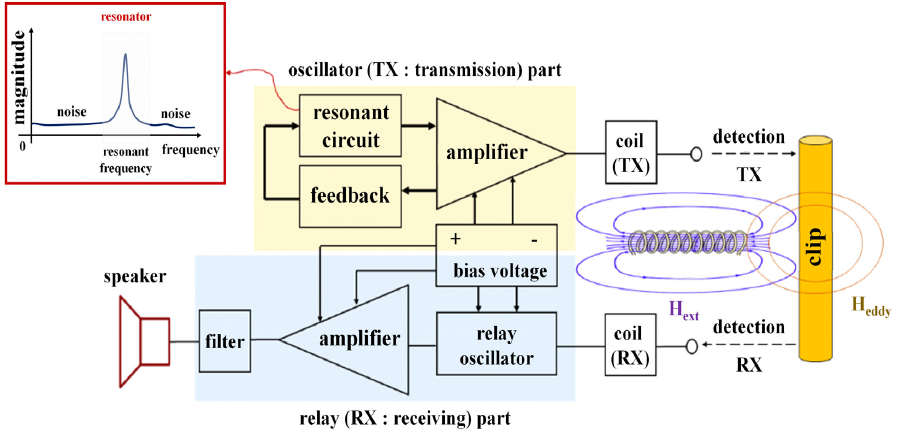
Figure 6. Block diagram of the clip-detector.